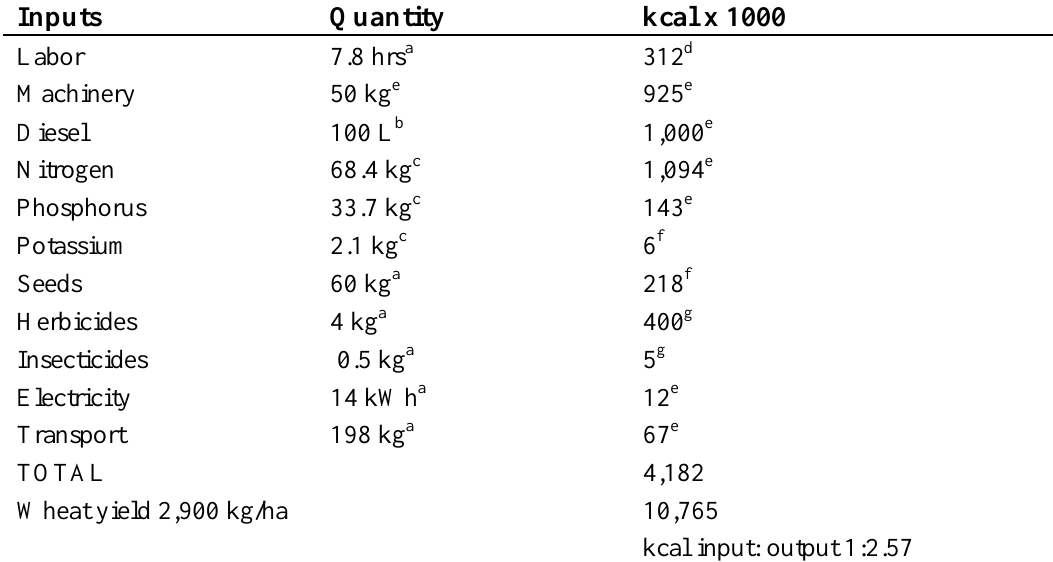
Table 7. Energy inputs of wheat production per hectare in the United States.